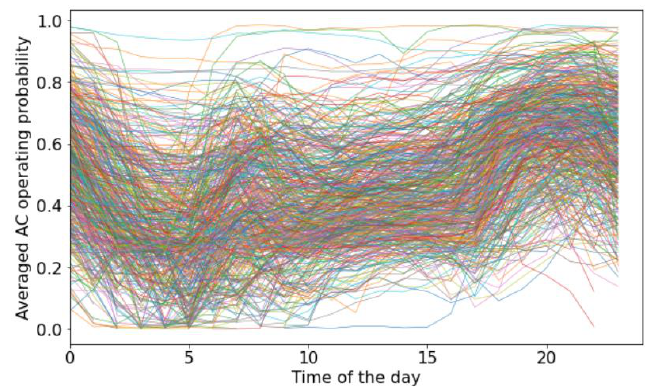
Figure 6. Hourly AC operating probabilities for all 482 dwellings.